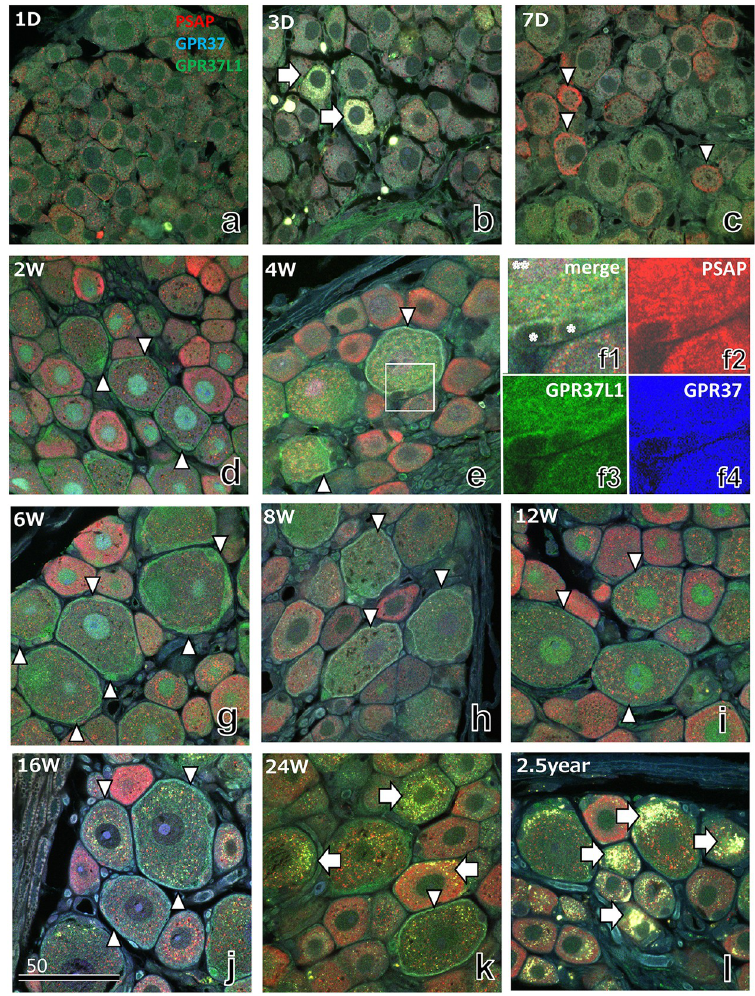
some small and damaged neurons (arrowheads in c and white arrows in b, respectively). From 2–12 weeks (d–i), some satellite cells showed strong staining of GPR37L1 (arrowheads in d–k). The area in the rectangle in Fig 5e is shown in higher magnification view (f1–f4). After 16 weeks, these cells were rare. Asterisks indicate the nuclei of satellite cells. Arrows in Fig 5k and 5l indicate lipofuscin granules with strong fluorescence. The numbers on the bars indicate the scale in μ